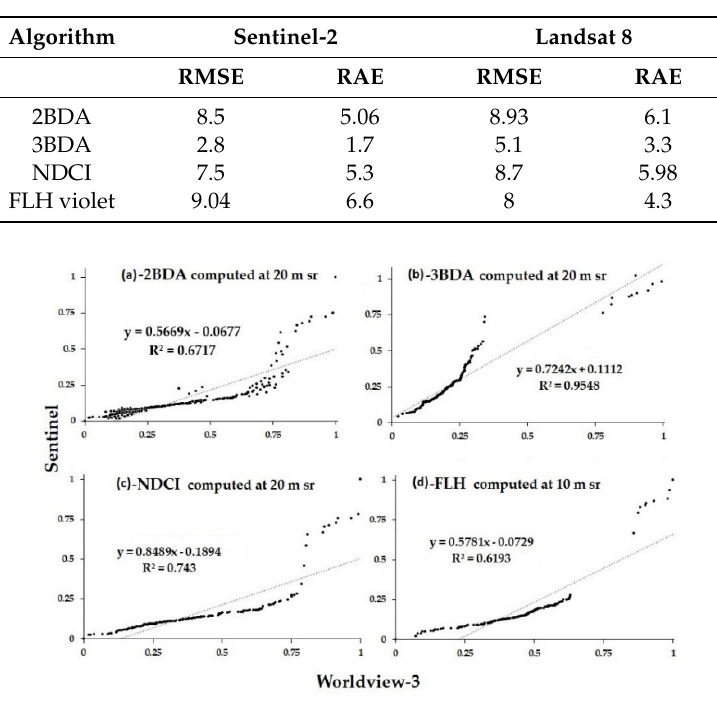
Table 4. Statistical performances of Chl a estimation algorithms used in this study.